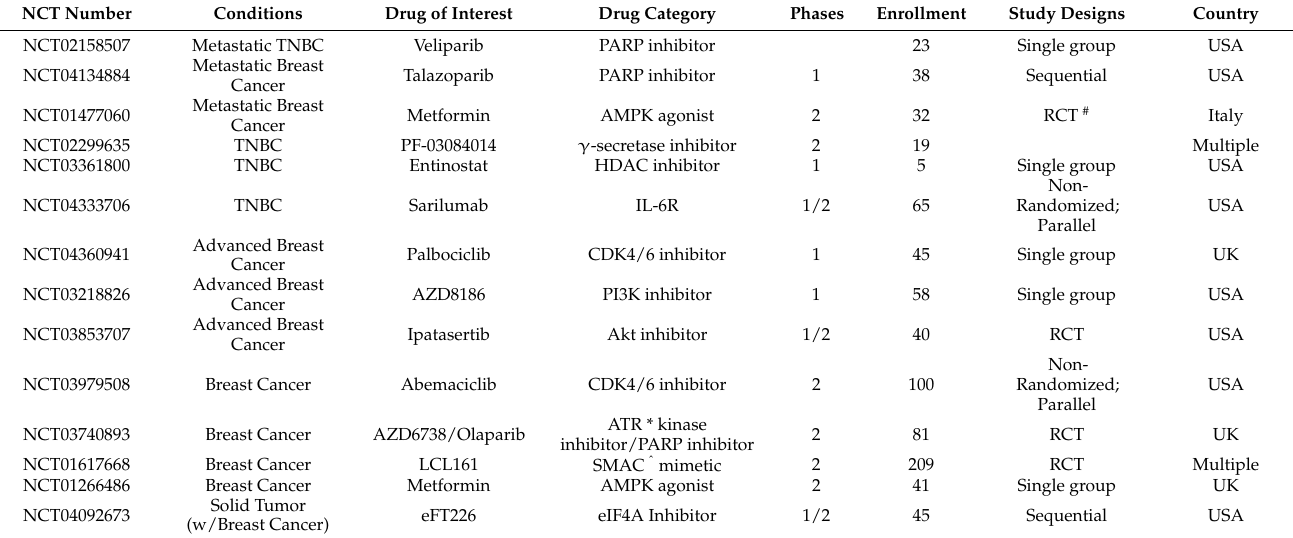
Table 2. Clinical trials treating chemoresistant breast cancer registered on